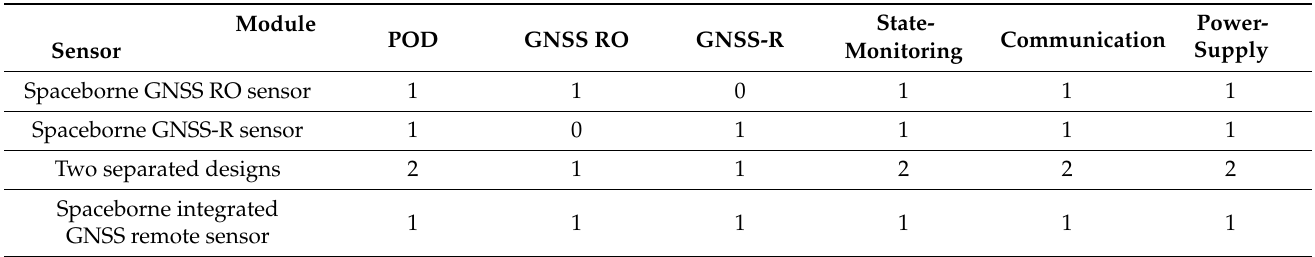
Table 1. Comparison of number of different modules between two separated designs, and the spaceborne integrated GNSS remote sensor.